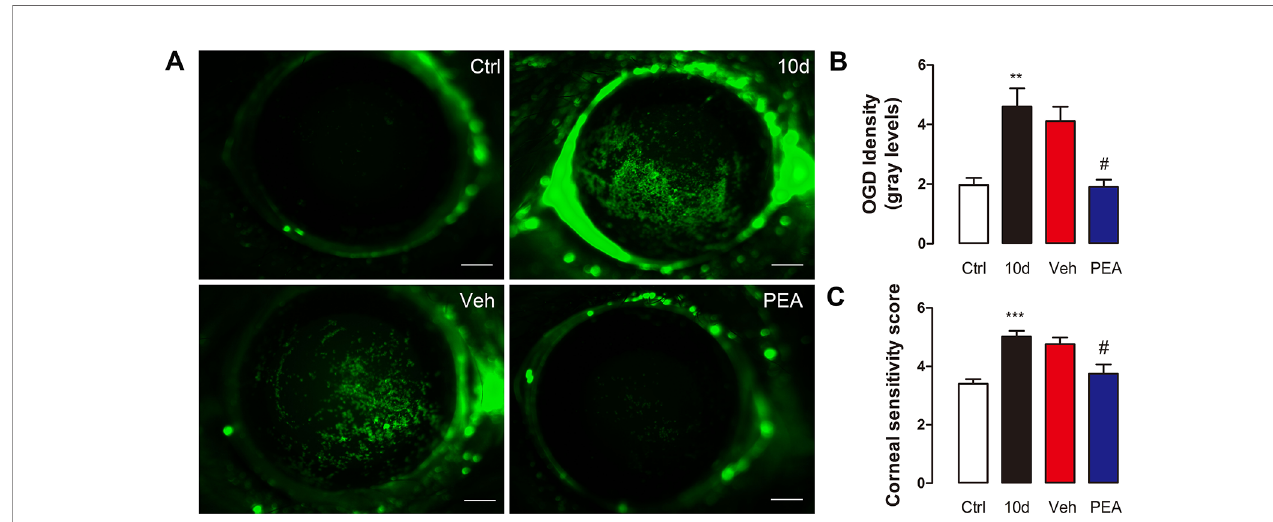
FIGURE 7 | PEA reduced the corneal epithelial permeability and nerve sensitivity. Representative digital pictures of Oregon Green Dextran (OGD) corneas staining used to score corneal epithelial permeability (A) , scale bars: 500 m m. OGD intensity scores (B) and corneal sensitivity scores (C) were expressed as mean ± SD in non-treatment control group (Ctrl), sleep deprivation (SD) for 10d group (10d), SD for 10d + solvent vehicle group (Veh), and SD for 10d + 30 mg/kg PEA treatment group (PEA). **, P < 0.01, ***, P < 0.001 vs. control group; # , P < 0.05 vs. vehicle group, one-way ANOVA followed by Dunette ’ s post hoc , n =